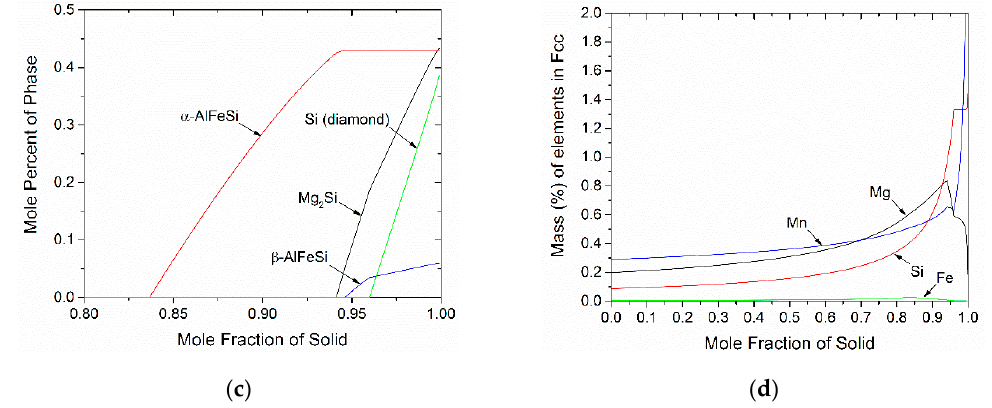
Figure 2. ( a ) Scheil solidification path for 6082 alloy, ( b ) mole percent of phases as a function of temperature, ( c ) mole percent of phases as a function of mass fraction solid and ( d ) mass percent of elements as a function of mass fraction solid during solidification of 6082 alloy.